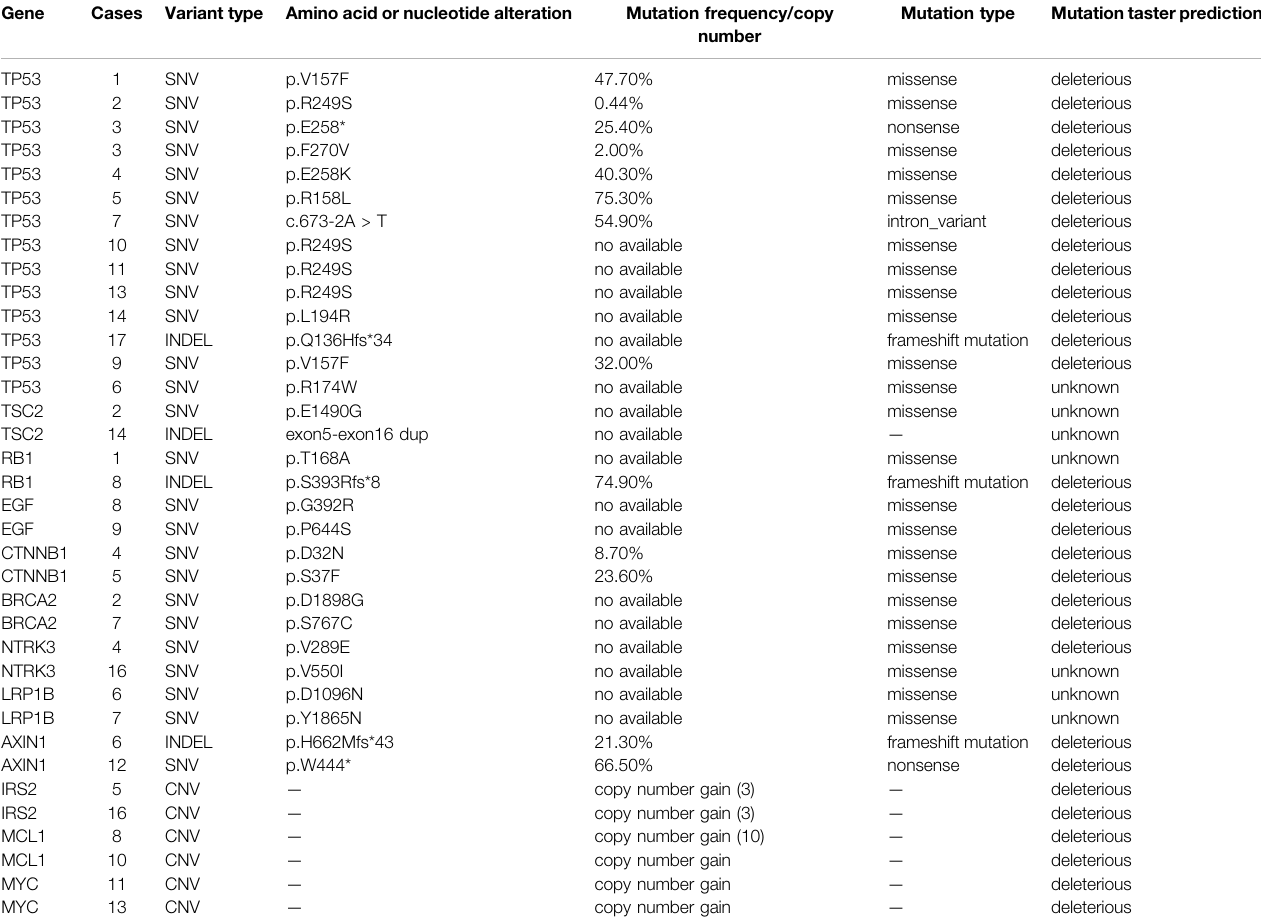
TABLE 2 | Summary of frequent gene variation in HCC detected by targeted sequencing. Gene Cases Variant type Amino acid or nucleotide